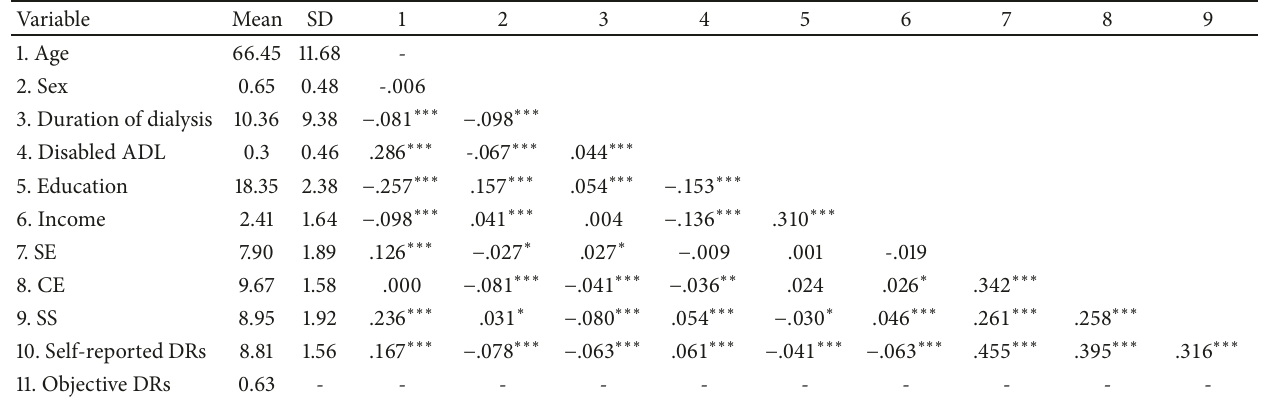
Table 1: Descriptive statistics and correlations among study